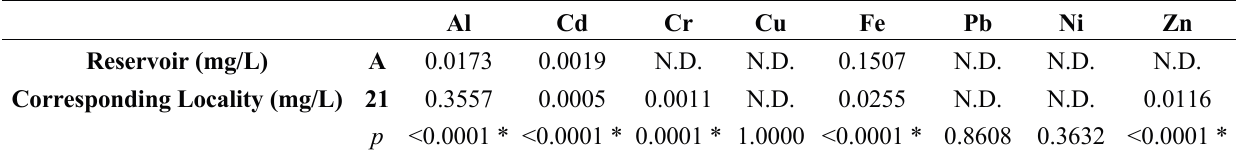
Table A1. Statistical variation between Reservoir A and its feeding Locality 21.